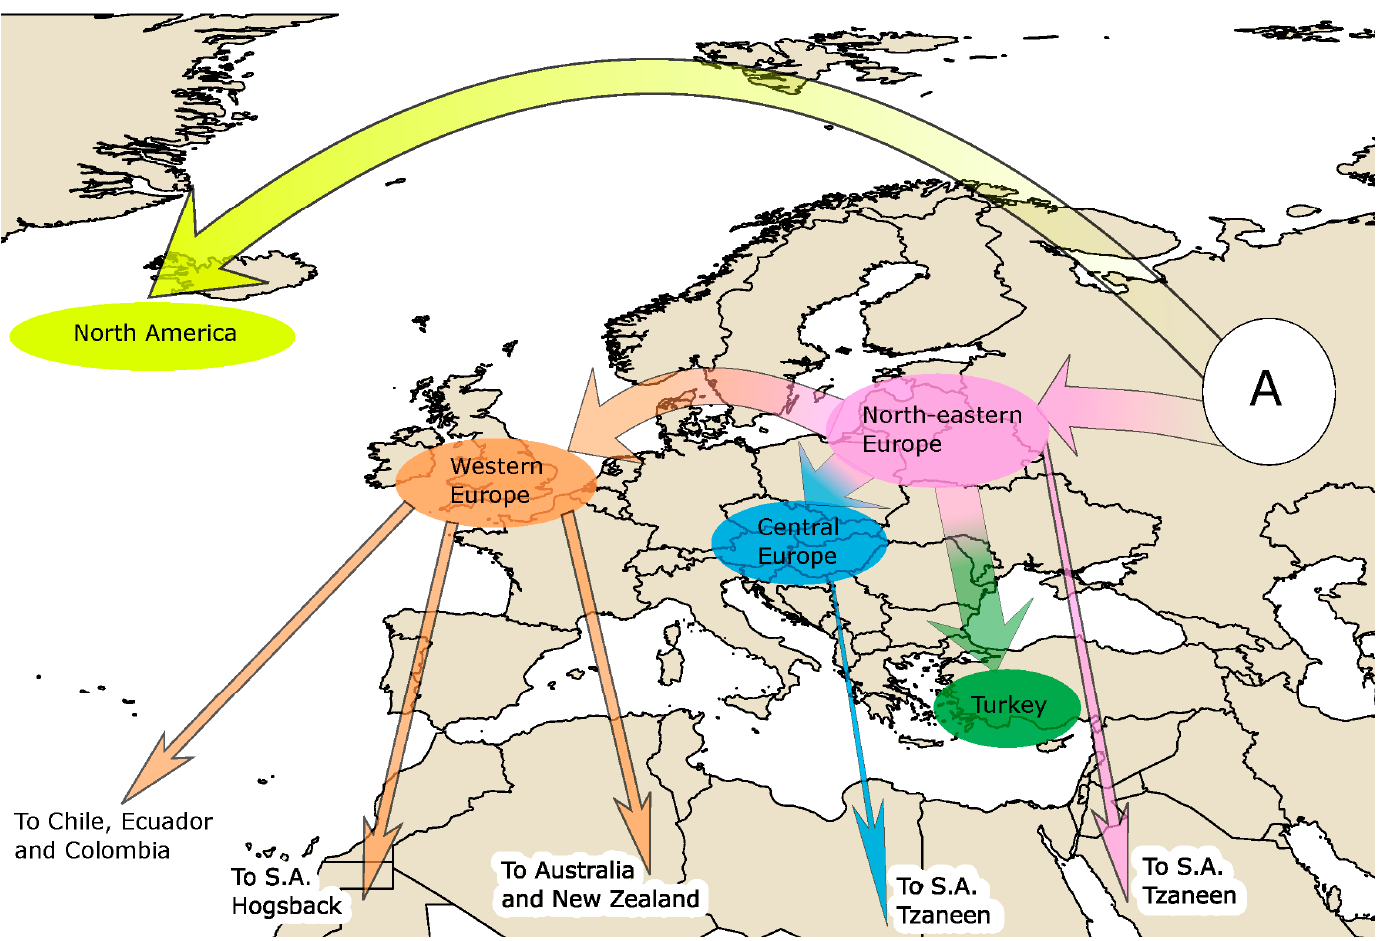
Figure 5. Graphical representation of D. septosporum migration pathways (marked by arrows) supported by STRUCTURE and DIYABC analyses. Ancestral population (A) gave rise to both the North American and Eastern European clusters and most likely resided in Eastern Europe and Western Asia. Colors of arrows and ellipses correspond to STRUCTURE cluster colors in Figure 2.